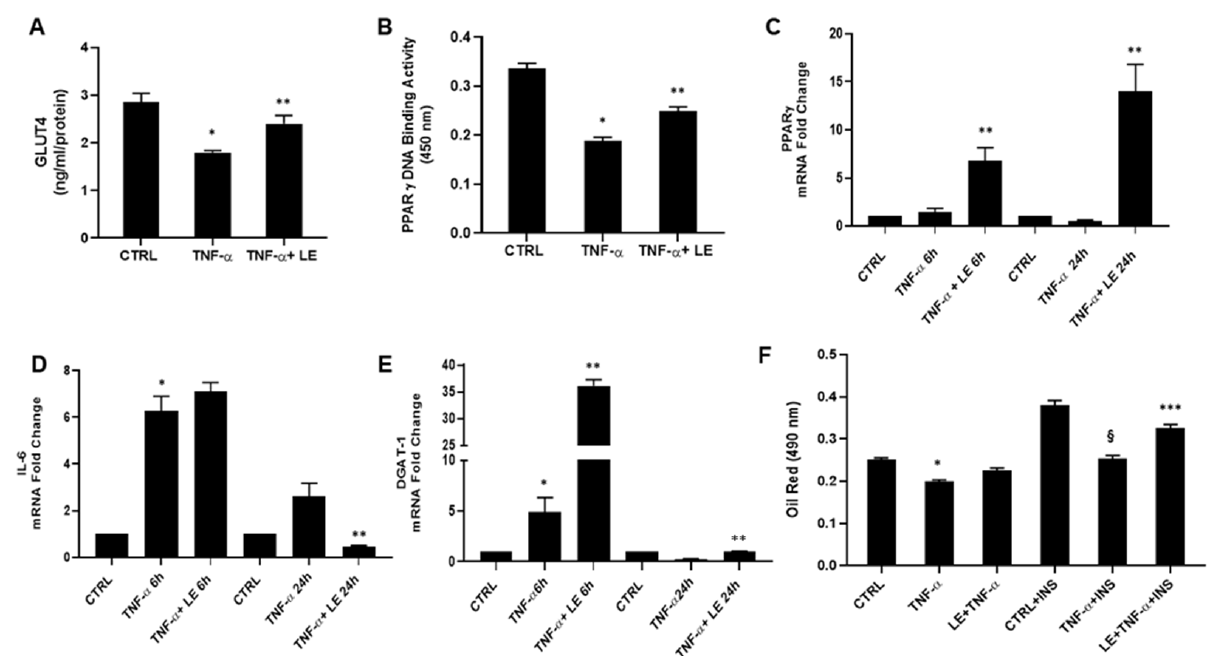
Figure 1. ( A ) Quantitative measurement of GLUT4 in cultured adipocytes treated with 100 ng/mL of TNF- α and 0.56 mg/mL of LE; ( B ) PPAR γ transcription factor DNA binding activity in nuclear extracts; ( C – E ) RT-qPCR for PPAR γ , IL-6 and DGAT-1 gene expression; ( F ) oil red O Staining in absence and presence of insulin (50 ng/mL). * p < 0.0001 CTRL vs. TNF- α , ** p < 0.005 TNF- α vs. TNF- α + LE, *** p < 0.0001 TNF- α + INS vs. LE + TNF- α + INS, § p < 0.0001 CTRL + INS vs. TNF- α + INS.